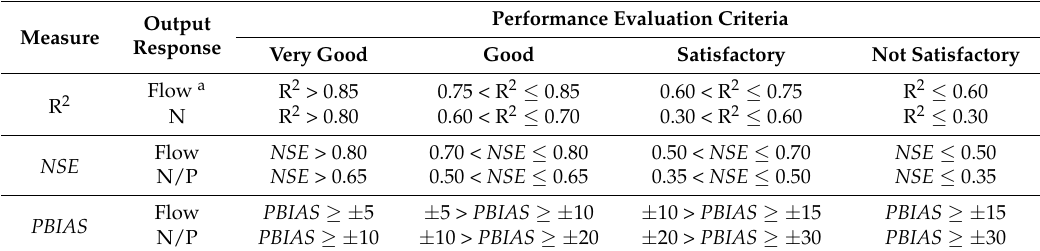
Table 2. General performance rating for recommended statistics [37].